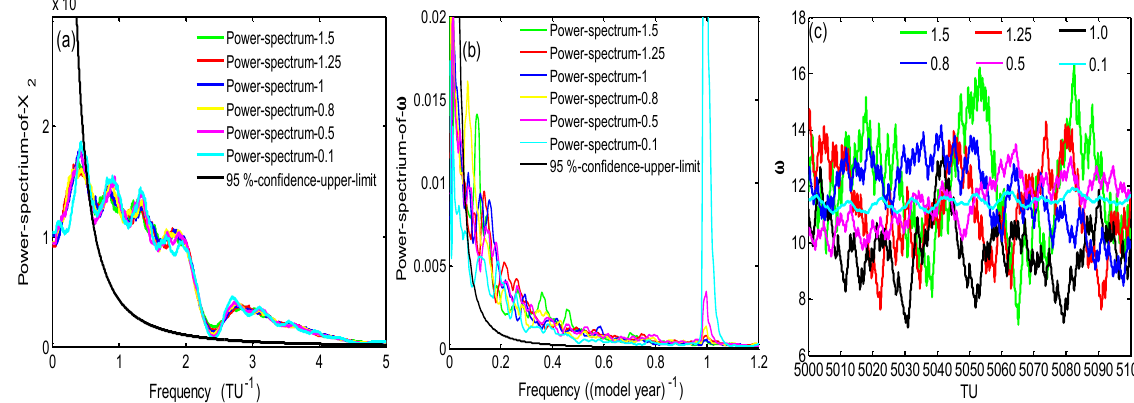
Figure 9. The power spectrum of (a) X 2 and (b) ω based on the model states between 5000 and 9800TUs integrations after the spinup which integrates for 10000TUs from the initial condition (0, 1, 0, 0, 0) with different coupling strengths ( C 2 is set as 1.5, 1.25, 1.0, 0.8, 0.5, and 0.1, while C 1 remains as 0.1). Panel (c) shows the time series of the model state ω between 5000 and 5100TUs integrations corresponding to the six cases.